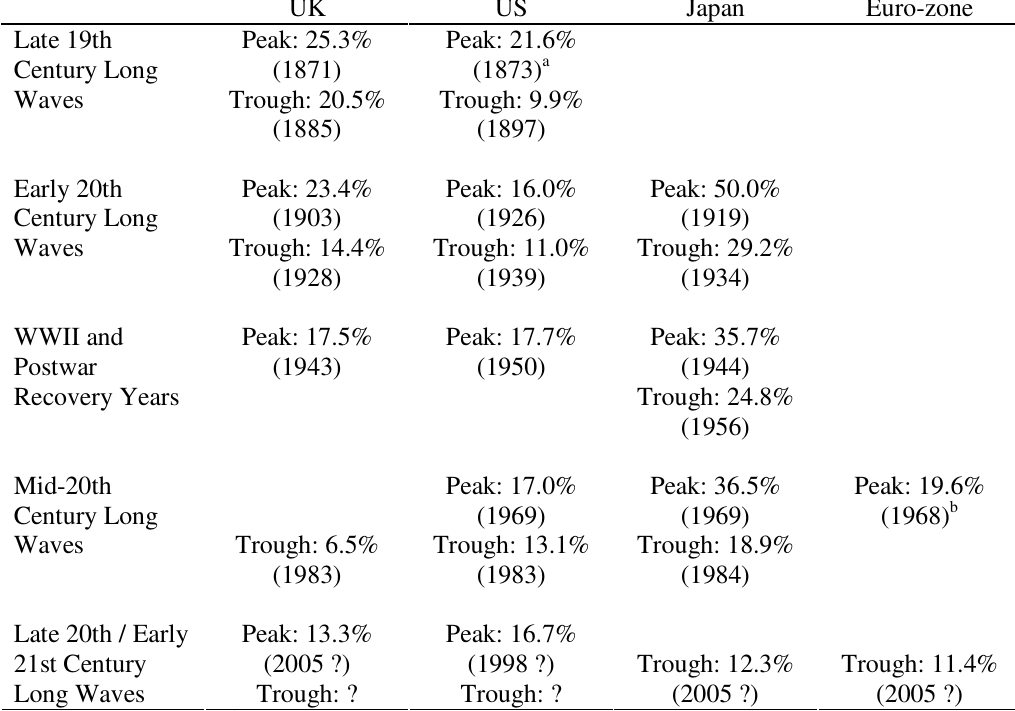
Table 1. The Profit Rate Long Waves: UK, US, Japan, and the